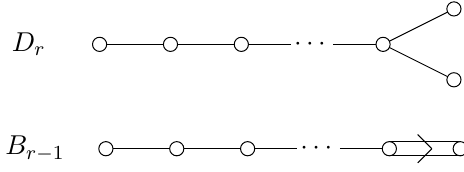
Figure 3 . Dynkin diagram D r (Lie algebra so (2 r ) ) has a Z 2 outer automorphism which interchanges its two branches. Folding it by average yields the Dynkin diagram B invariant subalgebra so (2 r − 1)